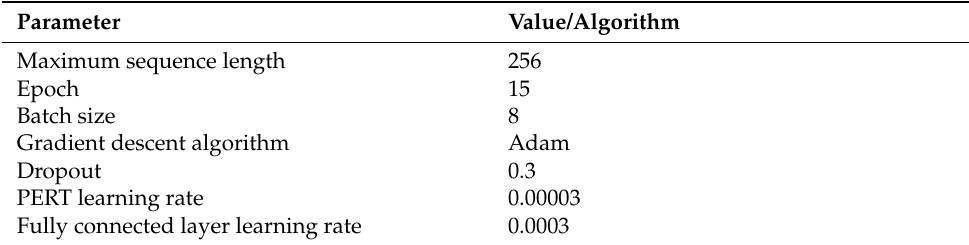
Table 6. Parameter settings.